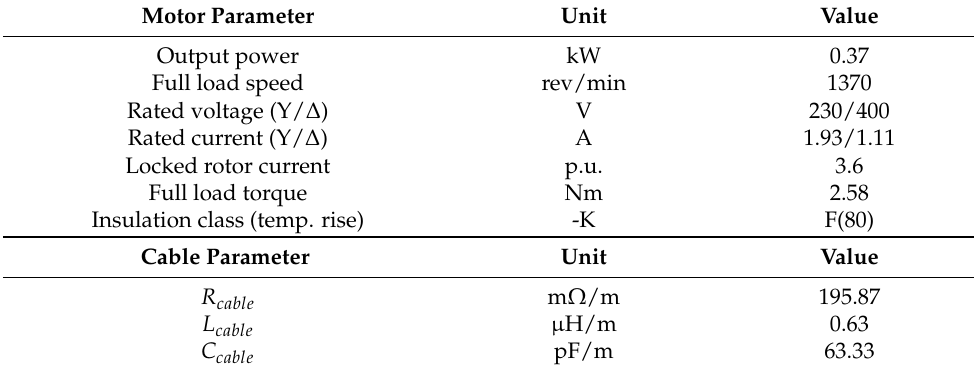
Table 4. Parameters of the cable and the motor under